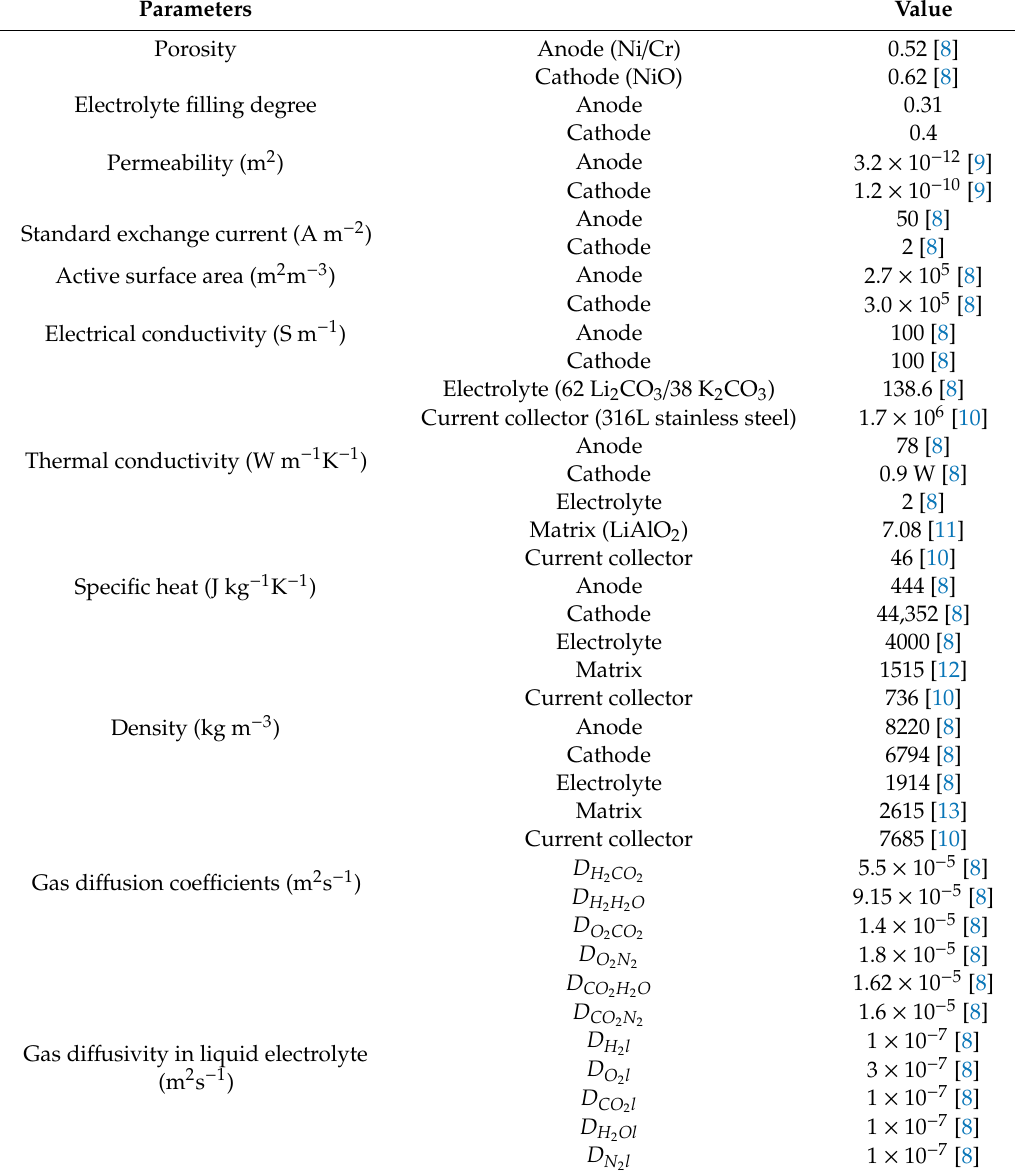
Table 2. Parameters of MCFC single